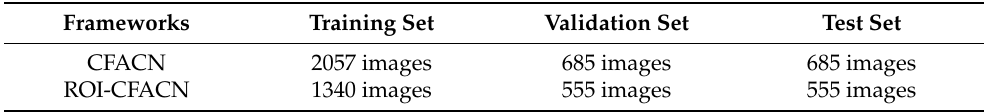
Table 1. The total number of collected